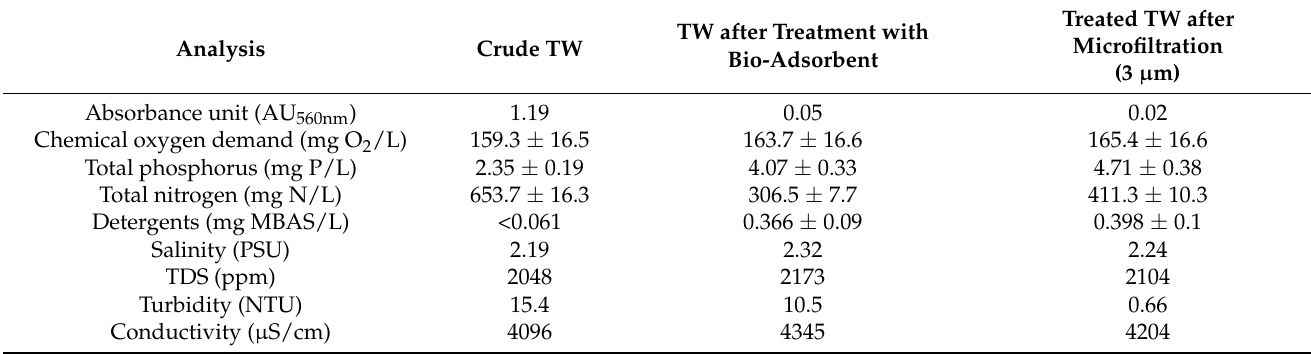
Table 5. Comparison of the composition of crude textile wastewater (TW), bio-adsorbent treated TW, and microfiltration (3 µ m) treated